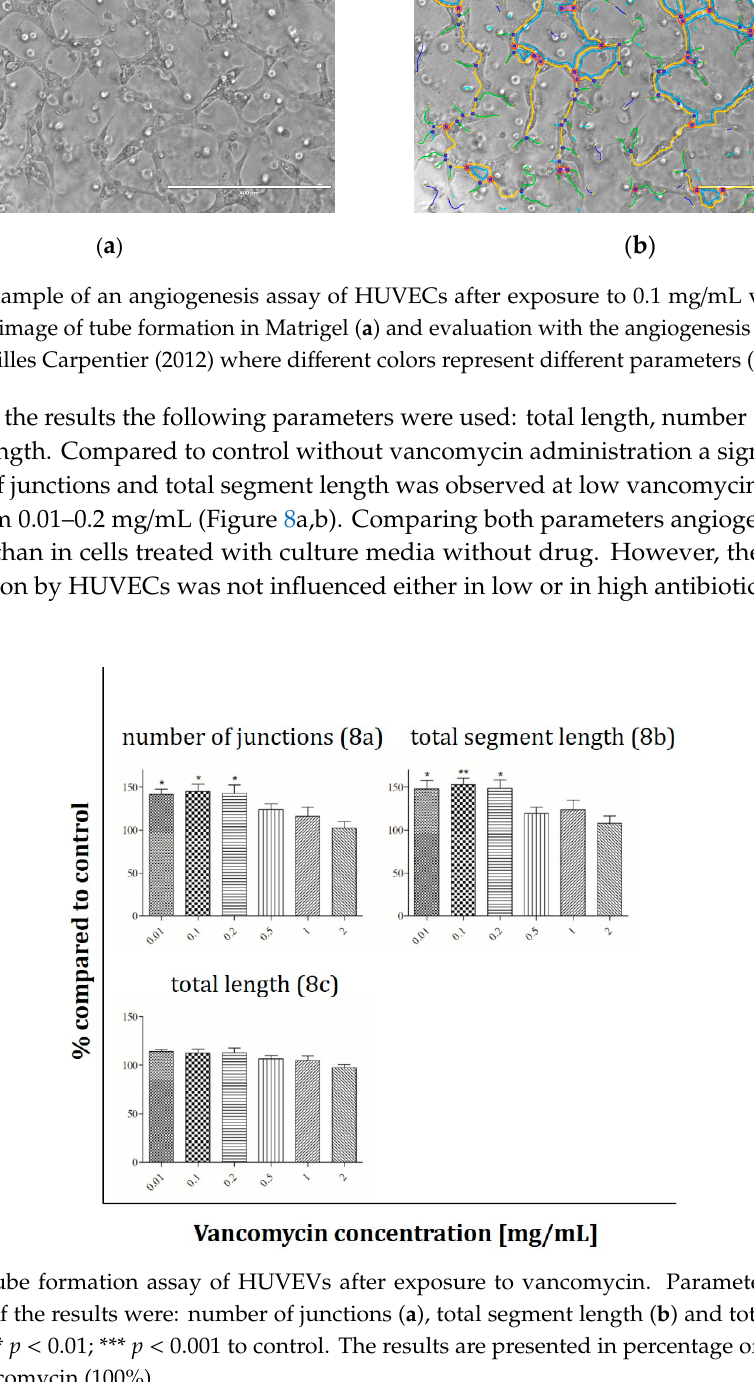
Figure 6. Proliferation of fibroblasts after exposure to vancomycin for 1, 3, 5 and 10 days with change of antibiotic every 4 days (* p ˂ 0.05; ** p < 0.01; *** p < 0.001 to control). The results are presented in percentage of the control without vancomycin (100%).